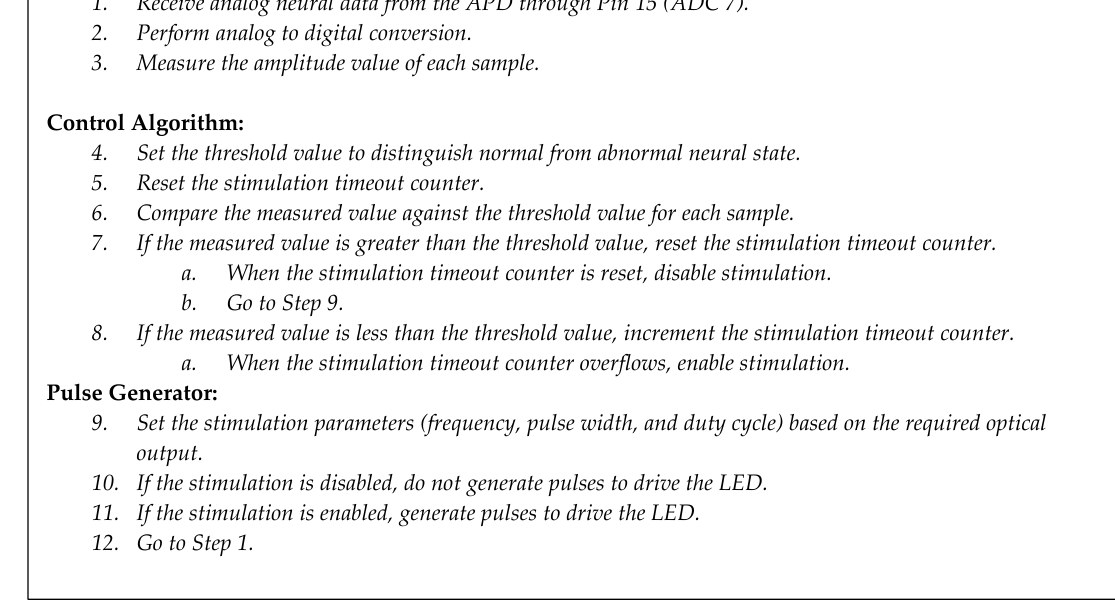
Figure 8. Pseudo-code for the software component.